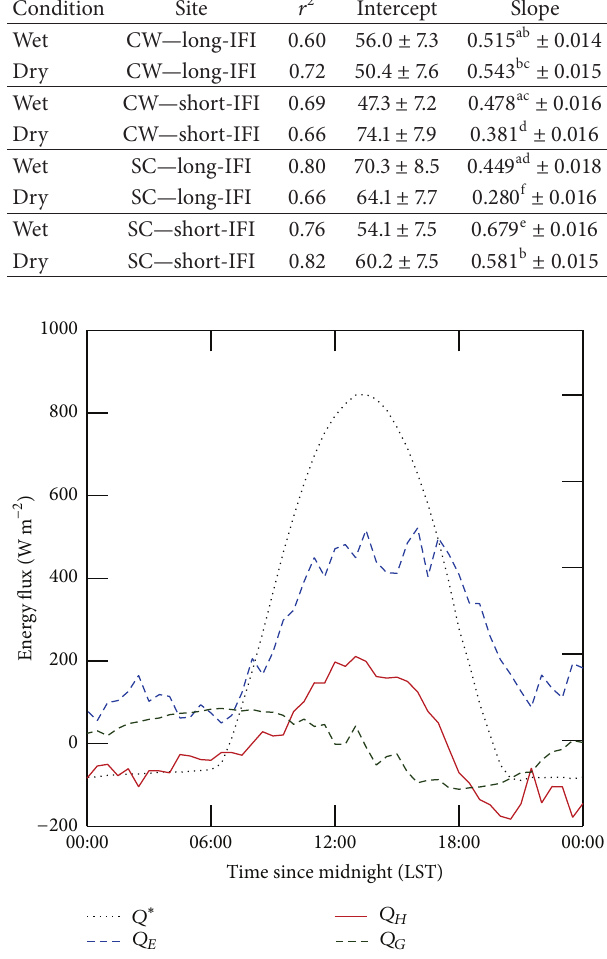
Figure 5: Half-hourly average energy fluxes at the inundated saltce- dar site (SC—short